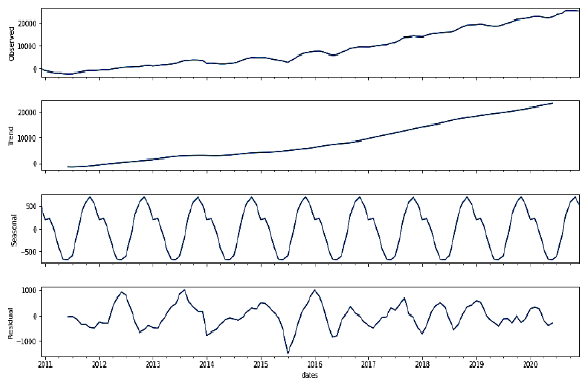
Figure 4. ETS decomposition of the cumulative EVI anomalies.